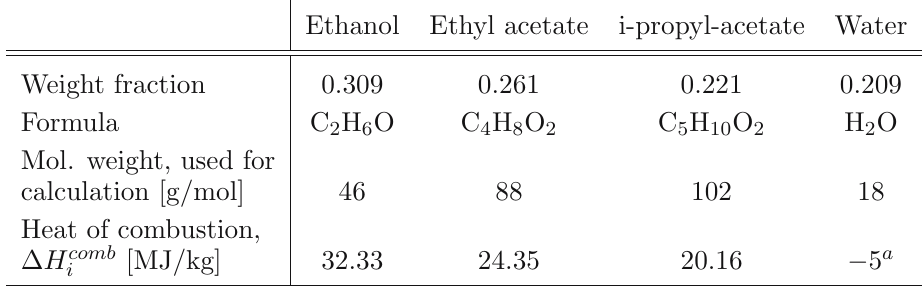
Table 1 The physical properties of waste solvent mixture